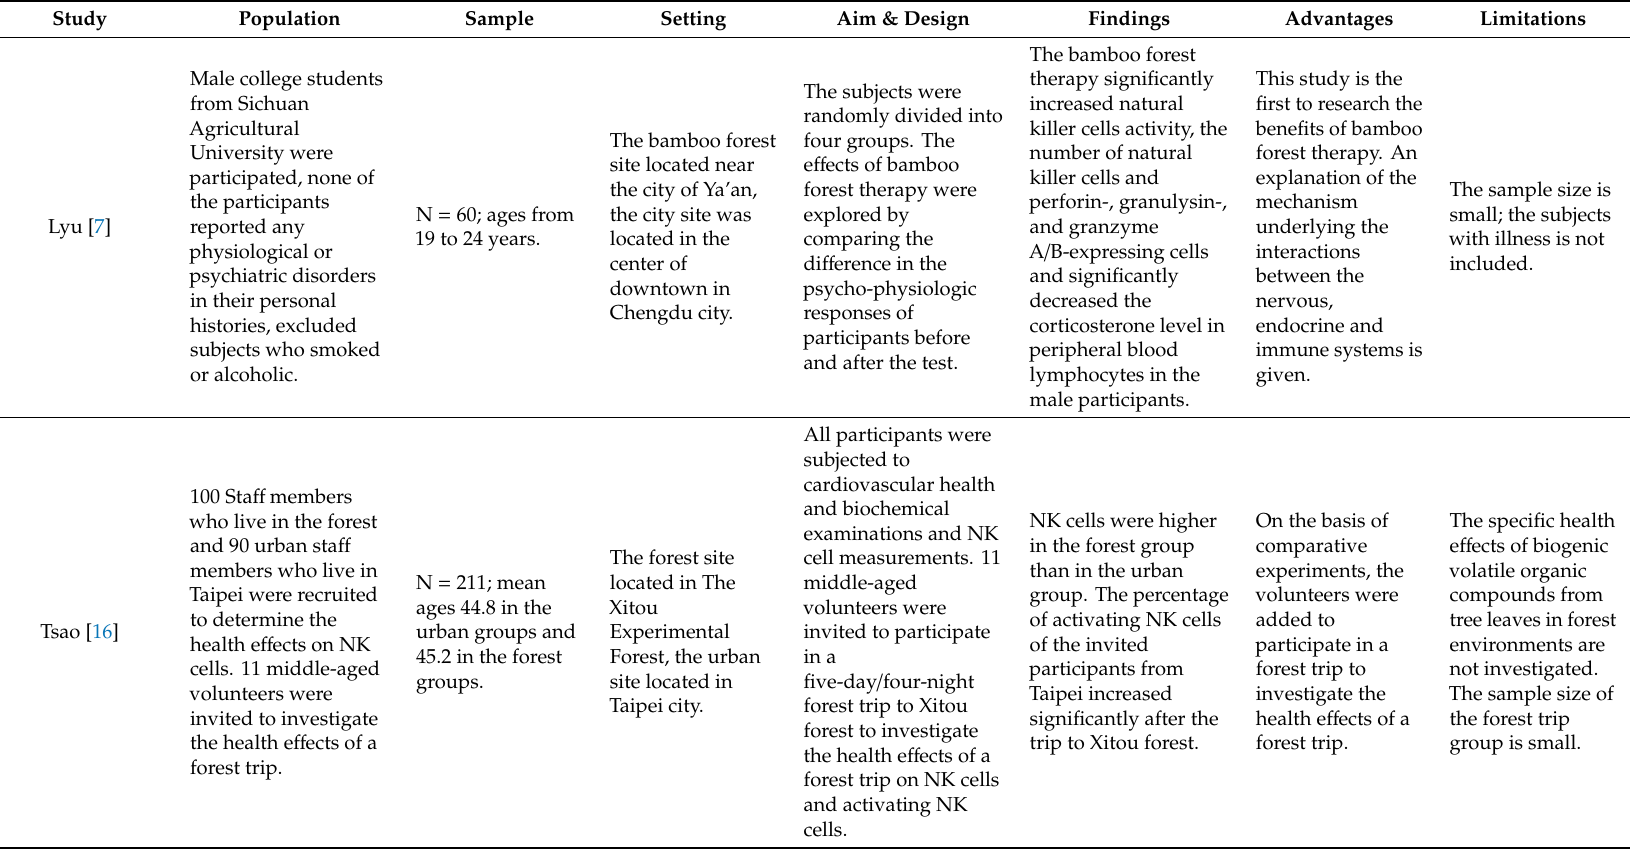
Table 1. Characteristics of selected studies about forest therapy in